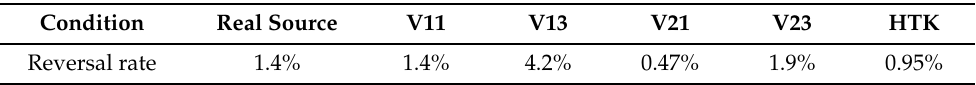
Reversal rates: Table 2 shows the reversal rates, defined as the percentages of re- sponses classified as front–back reversals. With real sources, this rate was equal to 1.4%. For virtual sources generated with V11, V21 and HTK, reversal rates were smaller or comparable to those of real sources (between 0.47% and 1.4%). Reversal rates were slightly higher for V23 (1.9%) and much higher for V13 (4.2%). Table 2. Reversal rate when localizing real sources in TestReal (Real Source) and virtual sources in TestVR (generated with V11, V13, V21, V23 and HTK). Condition Real Source V11 V13 V21 V23 HTK Reversal rate 1.4% 1.4% 4.2% 0.47% 1.9%